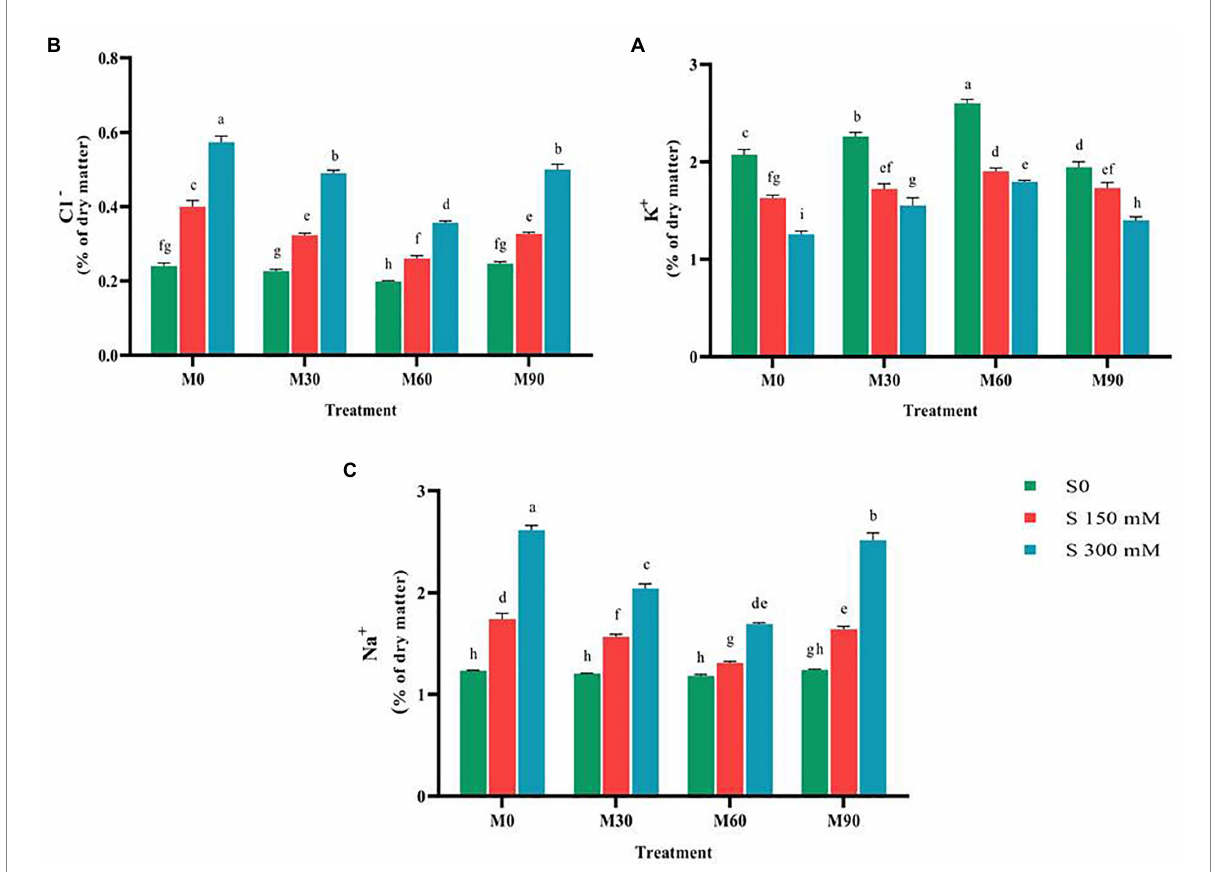
FIGURE 4 The mean comparison effects of melatonin concentrations and different levels of NaCl on (A) Potassium content, (B) Chlorine content, (C) Sodium content. Duncan method at 1% probability level was applied to compare mean values. The columns having similar letters had no significant